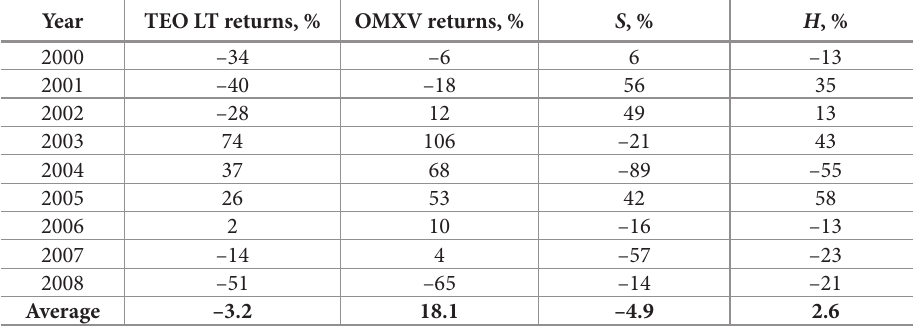
Table 4. Historical stock market results for the Fama-French model